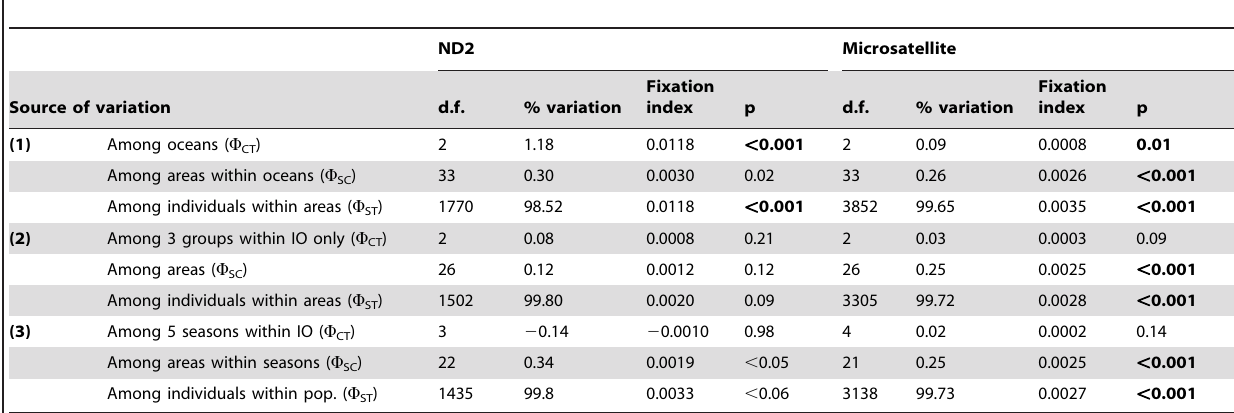
Table 2. Results of AMOVAs made for both markers according to different grouping (bold underline significant values).